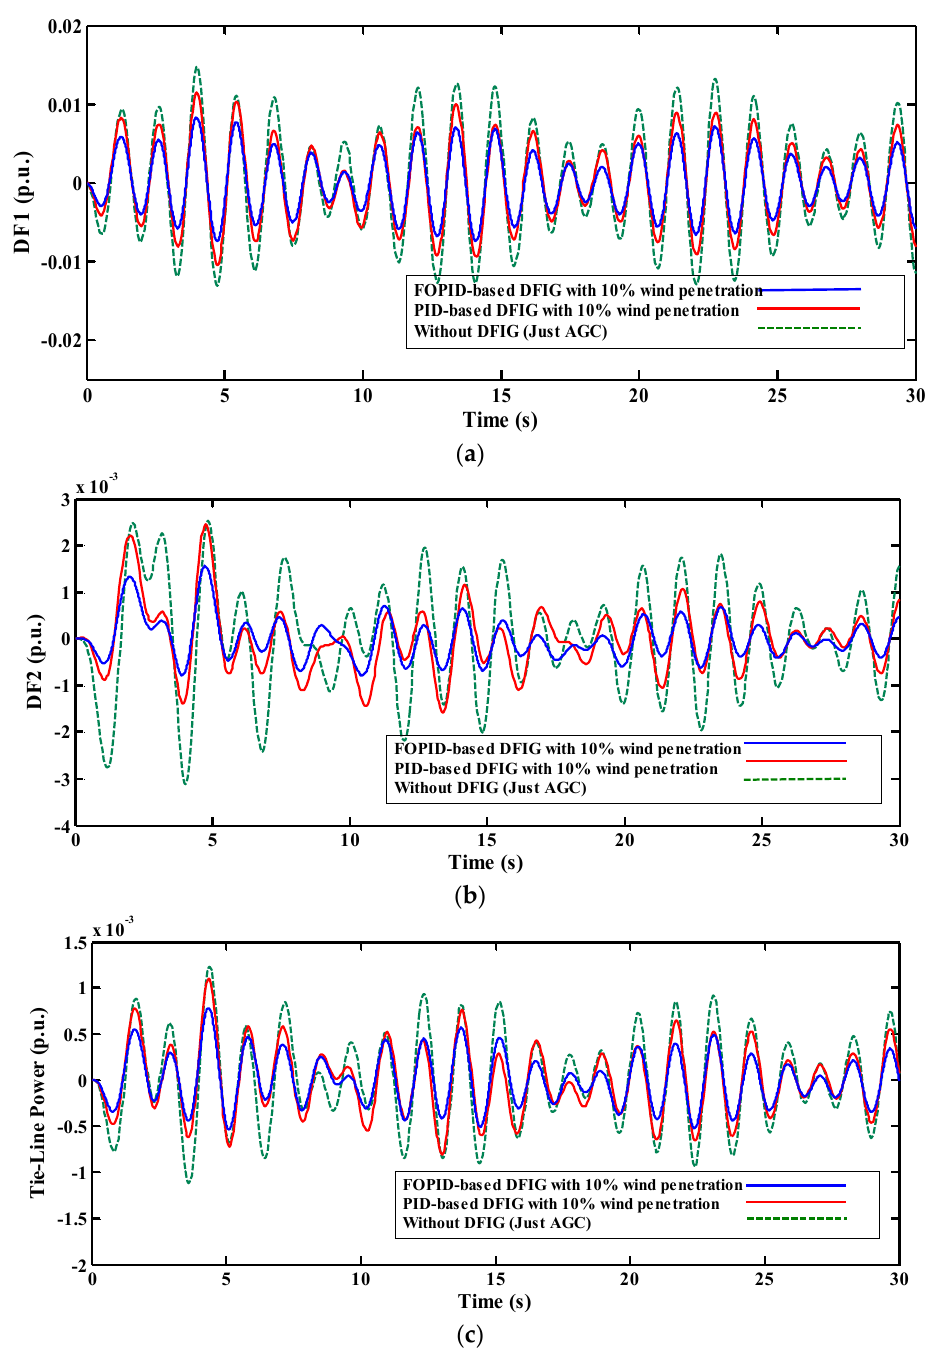
Figure 7. Frequency deviation and tie-line active power change in second scenario, ( a ) frequency deviation in area 1; ( b ) frequency deviation in area 2; and ( c ) tie-line power deviation.